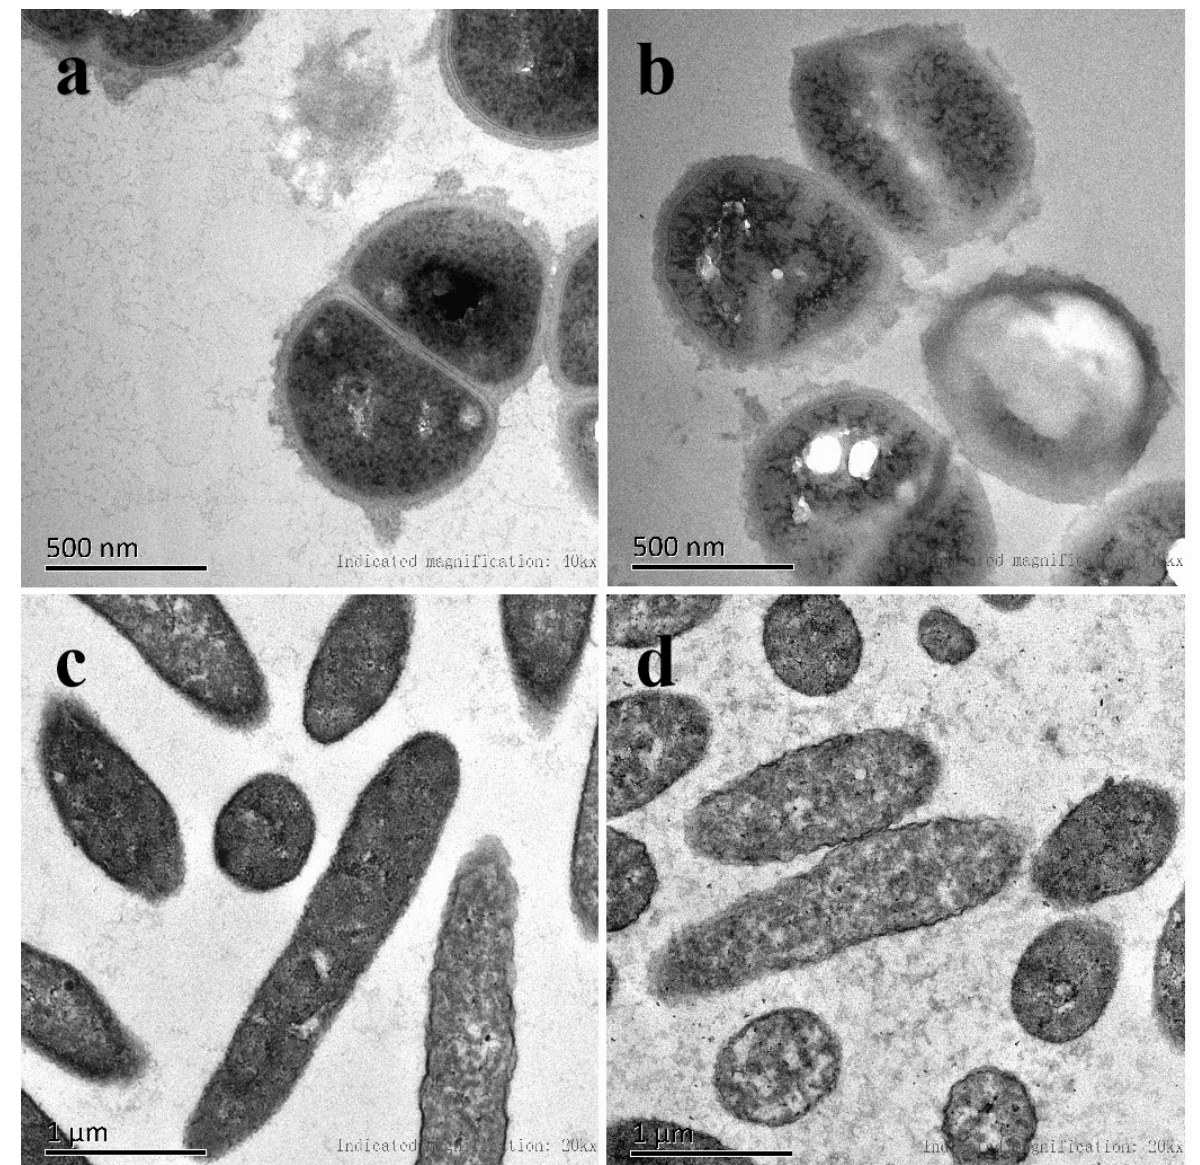
Figure 8. TEM images of S. aureus and P. fluorescens : ( a ) untreated S. aureus ; ( b ) S. aureus treated with 2 × MIC succinic acid; ( c ) untreated P. fluorescens ; and ( d ) P. fluorescens treated with 2 × MIC succinic acid.